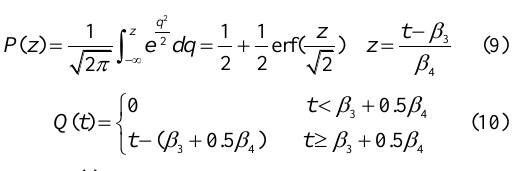
where t is the time interval for one gate; c is the light k velocity, c=299792458 m/s; n is the middle point of ret leading edge; and n is the pregiven tr